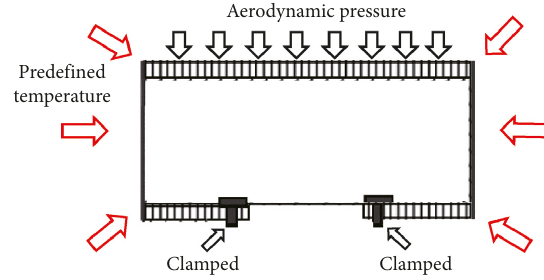
Figure 14: Thermal stress analysis model. Table 7: Initial values and boundaries of variables. Initial value Lower boundary Upper